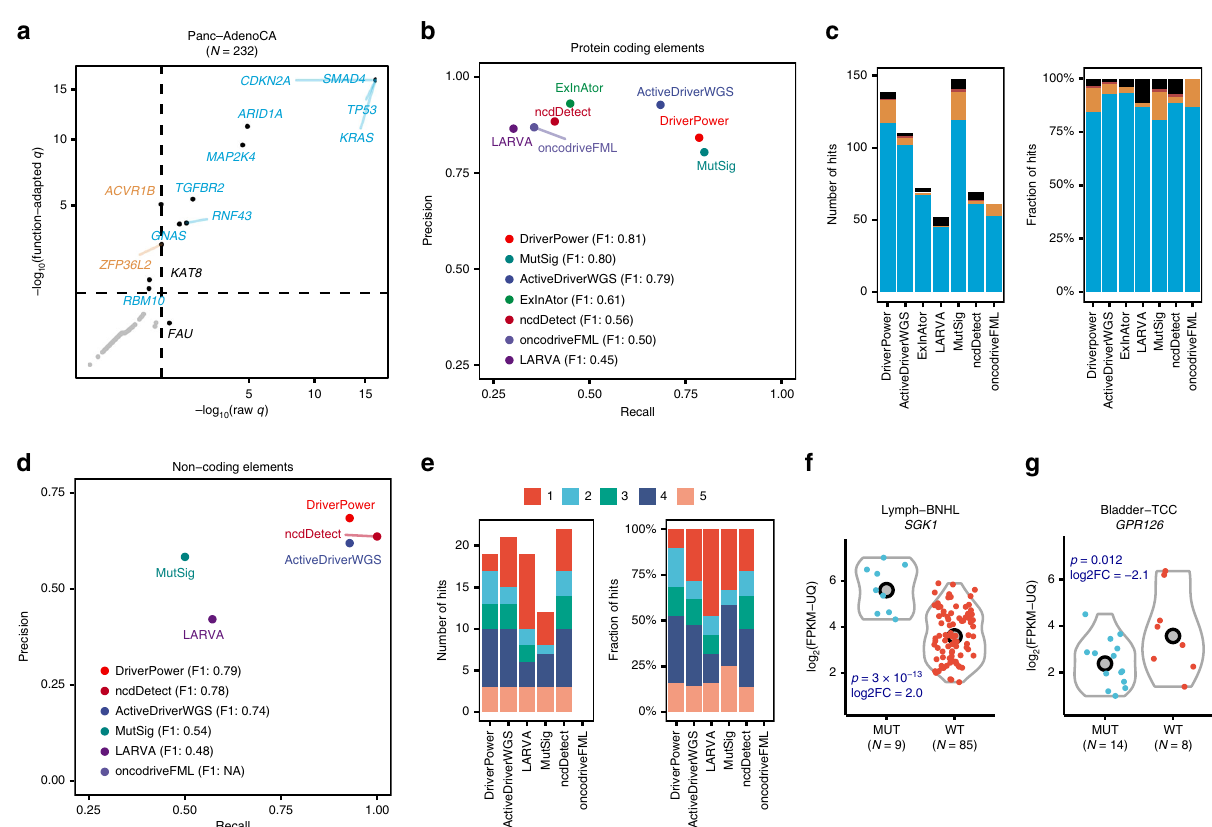
Fig. 2 Benchmarking DriverPower driver discovery performance. a Comparison of CDS results with or without functional adjustment for Panc-AdenoCA. Dashed lines in a represent the q value = 0.1 threshold. Function-adapted q values are q values with the incorporation of functional impact scores. Only signi fi cant genes are labelled (colour legend is the same as Fig. 1e). b , c Benchmark results for coding genes compared with six other driver discovery methods. d , e Benchmark results for 3 ′ -UTR, 5 ′ -UTR, promoter and enhancer sets. b , d Show the precision and recall for each method according to results of 26 tumour cohorts (no melanoma and lymphoma). c Shows the number and fraction of coding driver candidates called by each method that are contained within reference gene sets. The coloured columns in c correspond to different reference driver sets (colour legend is the same as Fig. 1e). e Shows the number and fraction of non-coding driver candidates called by each method that are also called by others. The coloured columns in e correspond to the number of methods that agree on a driver candidate. f Differential expression analysis for the CDS and splice site of SGK1 in Lymph- BNHL. g Differential expression analysis for the GPR126 enhancer in Bladder-TCC. MUT indicates samples with mutated element and WT indicates samples without mutated element. Copy number corrected p values from the likelihood ratio test and the log2 fold changes (log2FC) are shown in